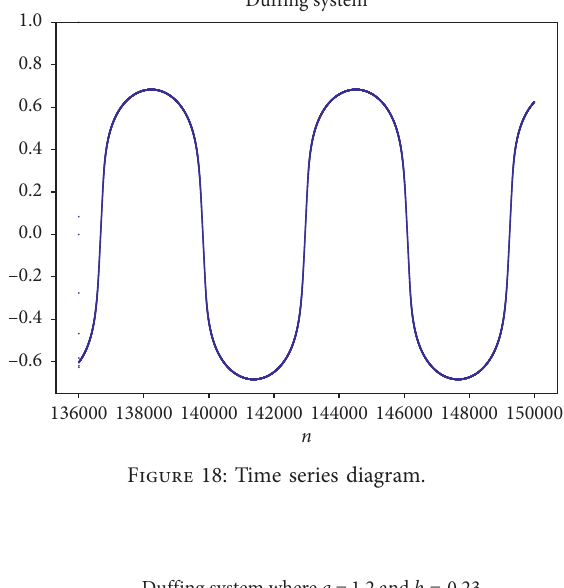
Duffing system where a = 1.9 and b = 0.23